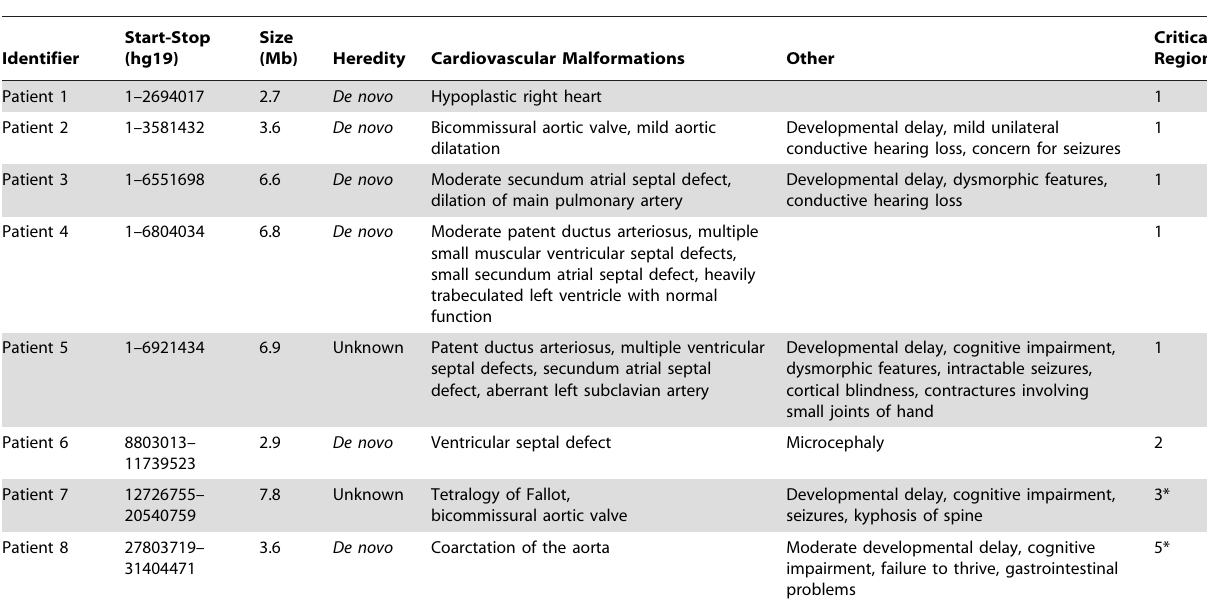
Table 1. Summary of individuals with isolated 1p36 deletions and cardiovascular malformations referred to the Medical Genetics Laboratory (MGL) at Baylor College of